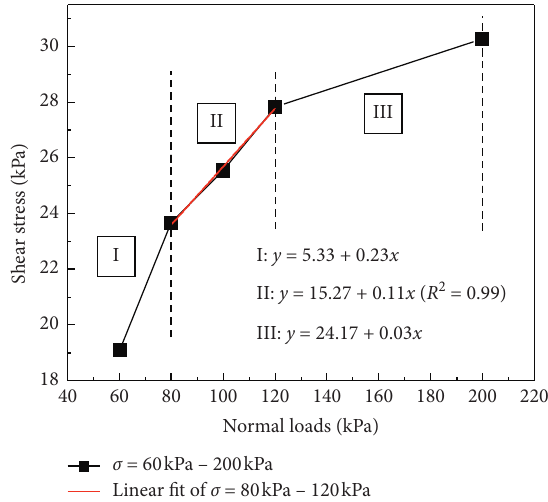
Figure 9: The relationship and fitting between the shear stress and the different normal loads.